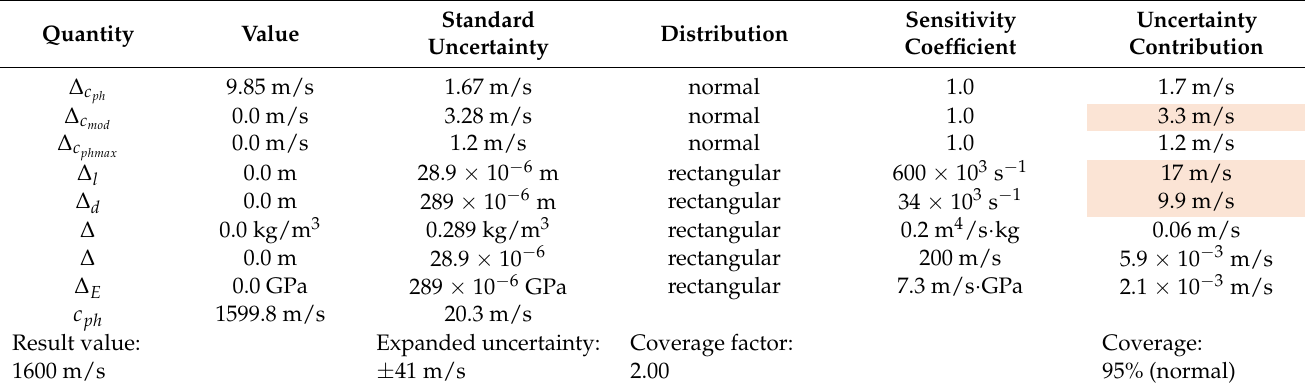
Table 5. The uncertainty budget of the combined uncertainty of the reconstructed frequency range (114.3–213.6) kHz for the A 0 mode. The shadows represent the dominant components.